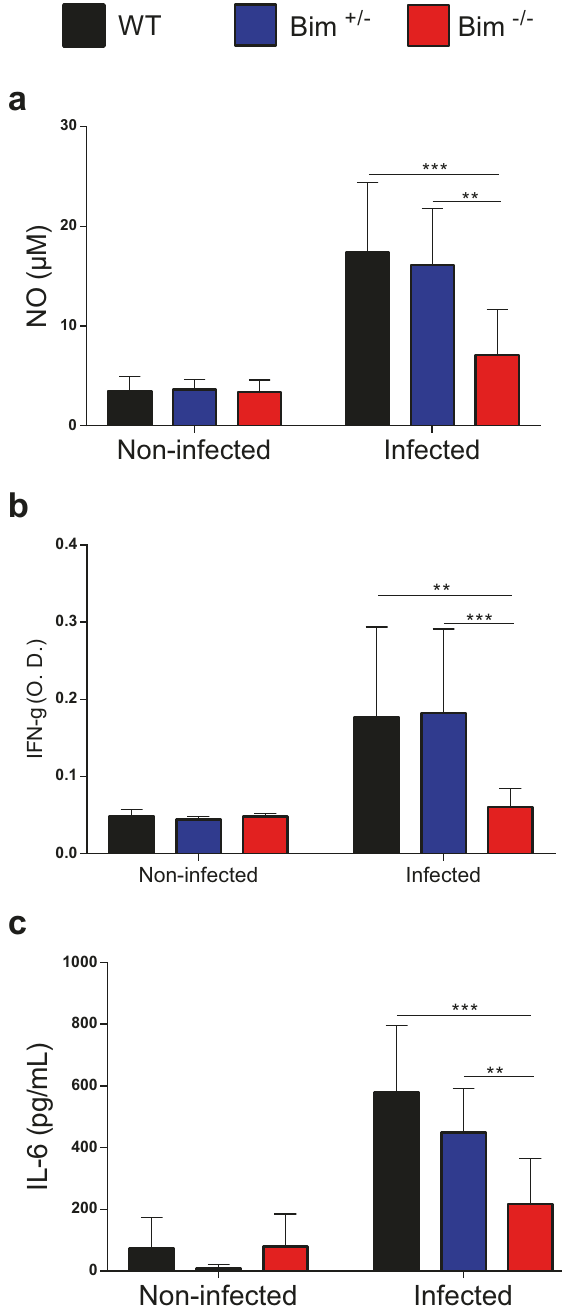
Fig. 3 Splenocytes from Bim − / − mice are de fi cient in NO, IFN- γ , and IL-6 production at peak parasitemia. Supernatants of splenocyte cultures of WT, Bim + / − , and Bim − / − C57BL/6 mice previously inoculated or not (9 days before) with 1 × 10 4 trypomas- tigotes of the Y strain of T. cruzi were collected after 24 h (IL-6) and 48 (NO, IFN- γ ) of incubation. A The concentration of nitric oxide (NO) was determined by the Griess reaction. B , C IFN- γ and IL-6 concentration were determined by capture ELISA assay. Statistical analysis was performed using two-way ANOVA, followed by Bonferroni post-test. * p < 0.05, *** p <